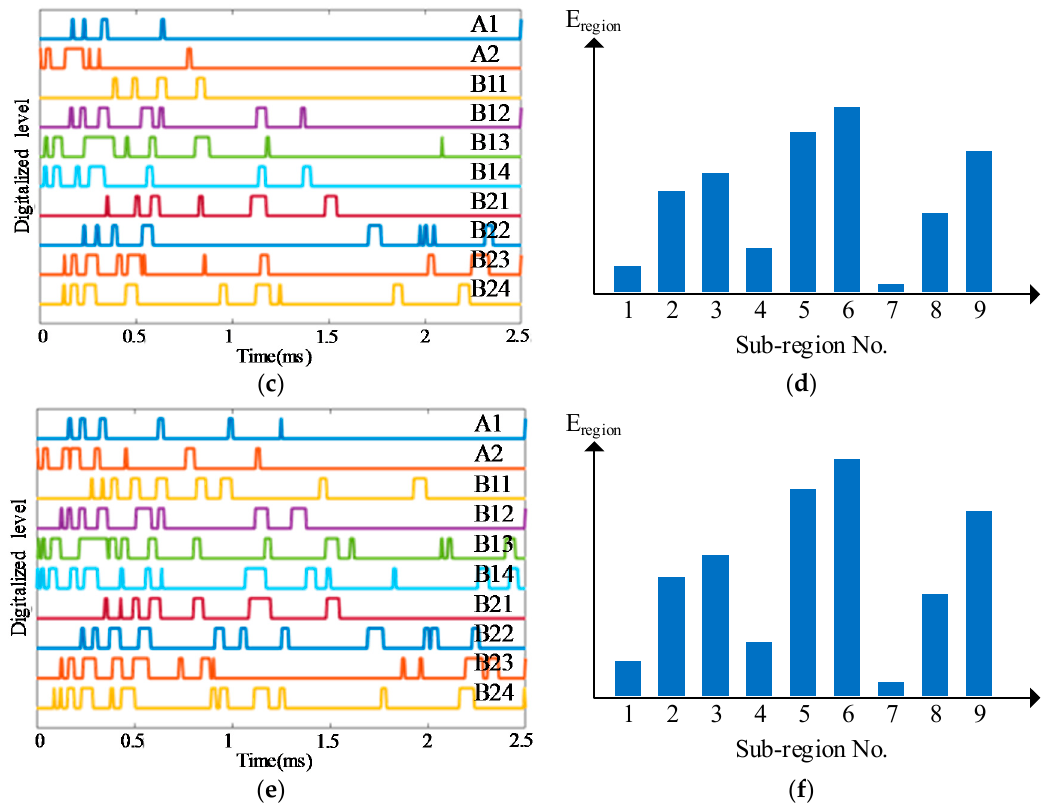
Figure 21. Typical impact region monitoring results on the glass fiber laminate plate based on CHSN under different energy levels: ( a ) CDSs and ( b ) E region of all sub-regions under energy level 1; ( c ) CDSs and ( d ) E region of all sub-regions under energy level 2; ( e ) CDSs and ( f ) E region of all sub-regions under energy level 3. Table 3. The impact region localization results on the glass fiber laminate plate.